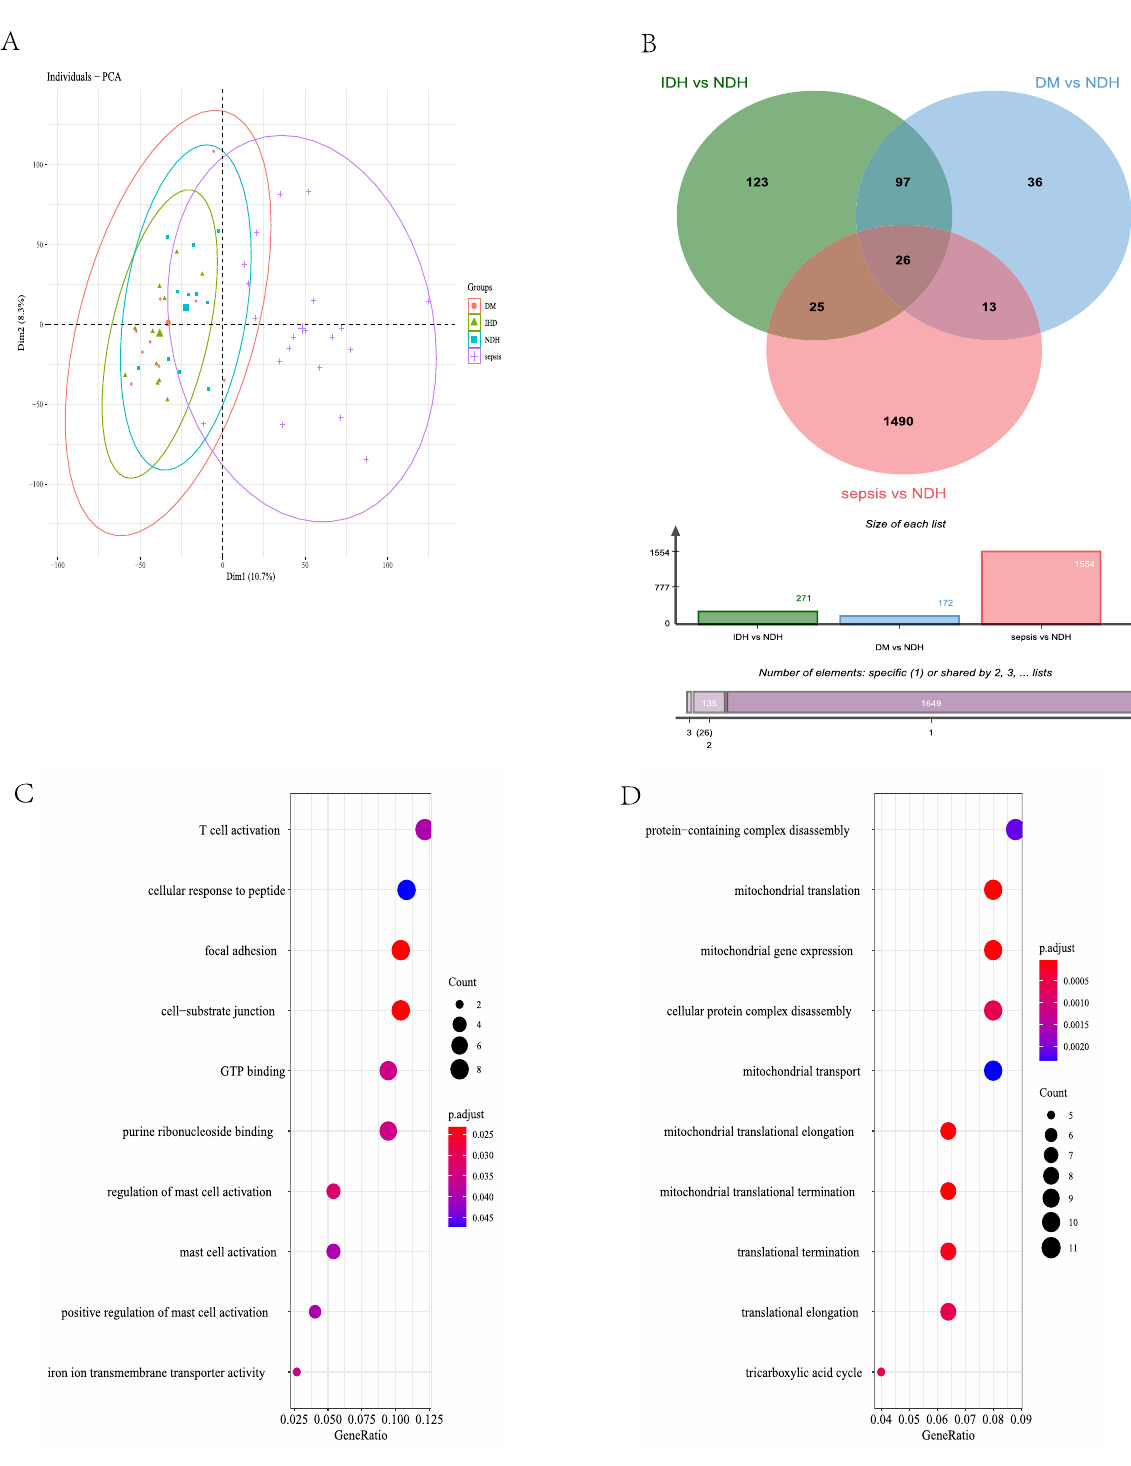
Figure 2. Principal component analysis (PCA) and differentially expressed gene (DEG) identification. ( A ) PCA of the myocardium dataset; the sepsis group is separated from other groups. Dim1 and Dim2 are the principle components 1 and 2 generated by PCA; the distribution plot presents the distribution of different group of myocardium sample. ( B ) Venn diagram of intersection of DEGs between NFH, IHD, sepsis, and DCM. ( C ) Gene ontology (GO) annotation of the common upregulated DEGs. ( D ) GO annotation of the common downregulated DEGs. SCM: septic cardiomyopathy, IHD: ischemic heart disease, DCM: dilated cardiomyopathy, NFH: non-failing